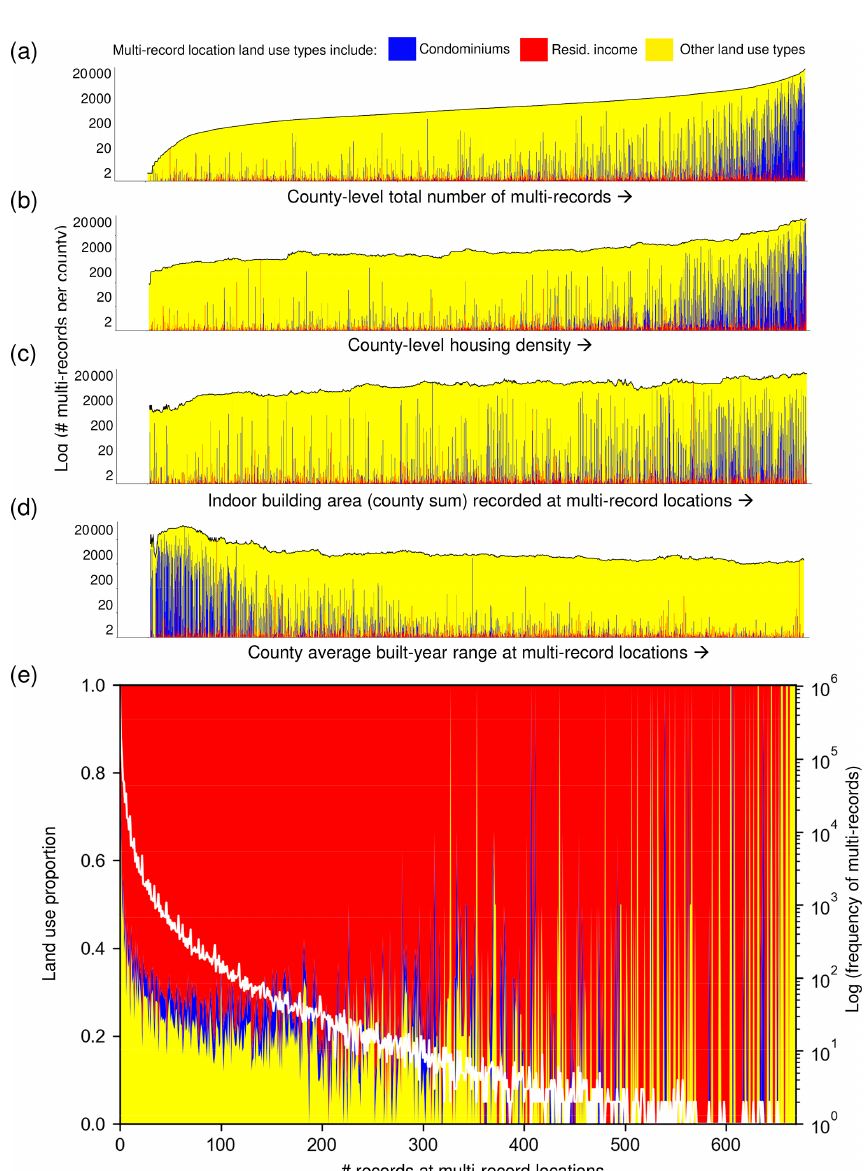
Figure D1. Detailed analysis of multi-record locations across different domains: stacked bar plots with each bar representing the proportions of involved land use types at multi-record locations per county. Lengths of the bars represent the log-transformed total number of multi- records per county, and the horizontal sorting of the bars from left to right is based on (a) the number of multi-records per county, (b) the county-level housing density derived from 2010 US census data (see Sect. 3.2.3), (c) the sum of indoor building area over all multi-records per county, and (d) the built-year range recorded at multi-record locations (county averages). (e) Distributions of the number of records at multi-record locations and their land use proportions, overlaid with the log-transformed total number of multi-records (white). Sorted data series in (a) – (d) were smoothened by a sliding median filter (size = 50) for improved